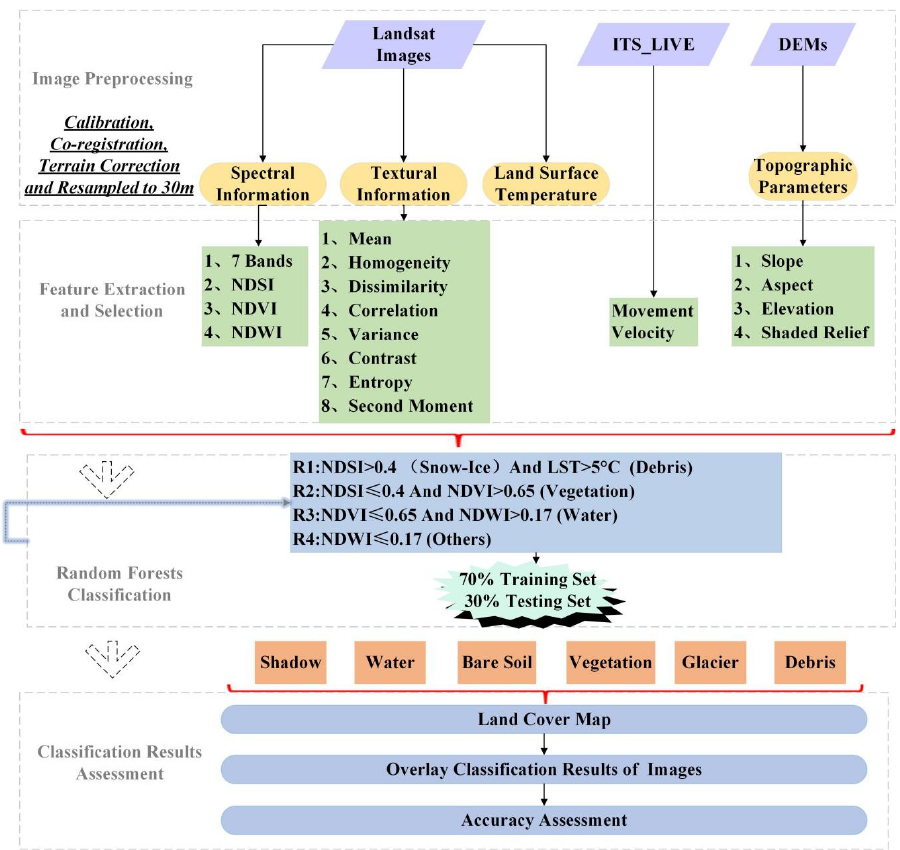
Figure 7 . The flowchart of the automatic glacier classification. Figure 7. The flowchart of the automatic glacier